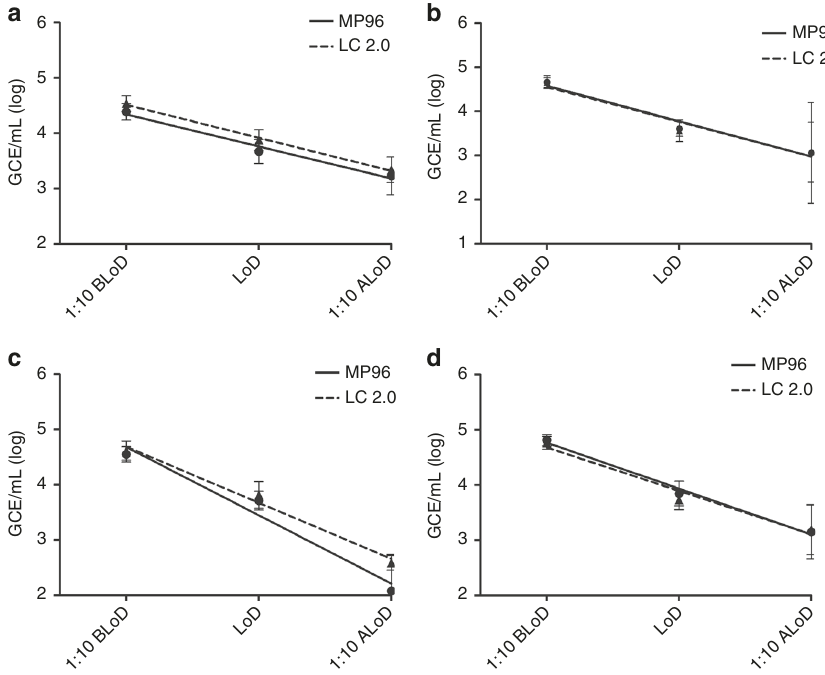
Fig. 2 Analytical performance comparison between MP96 and LC 2.0 RNA extraction platforms in serum and urine. a Normal human serum or b urine pooled from healthy donors was contrived with ZIKV at a dilution of 1:10 before the limit of detection (1:10 BLoD), at the limit of detection (LoD), and at 1:10 after the limit of detection (1:10 ALoD). Twenty replicates of each dilution were extracted using the small volume protocol (0.2 mL) and were tested with the Trioplex assay on the ABI7500 Fast Dx instrument. The same serum ( c ) and urine ( d ) dilutions were tested on the QuantStudio Dx instrument. Mean genome copy equivalents per milliliter (GCE/mL) of viral RNA detected are displayed at each dilution. Error bars represent GCE/mL standard deviation. Straight line represents linear regression of MP96 platform (Roche). Dashed line represents linear regression of LC 2.0 platform